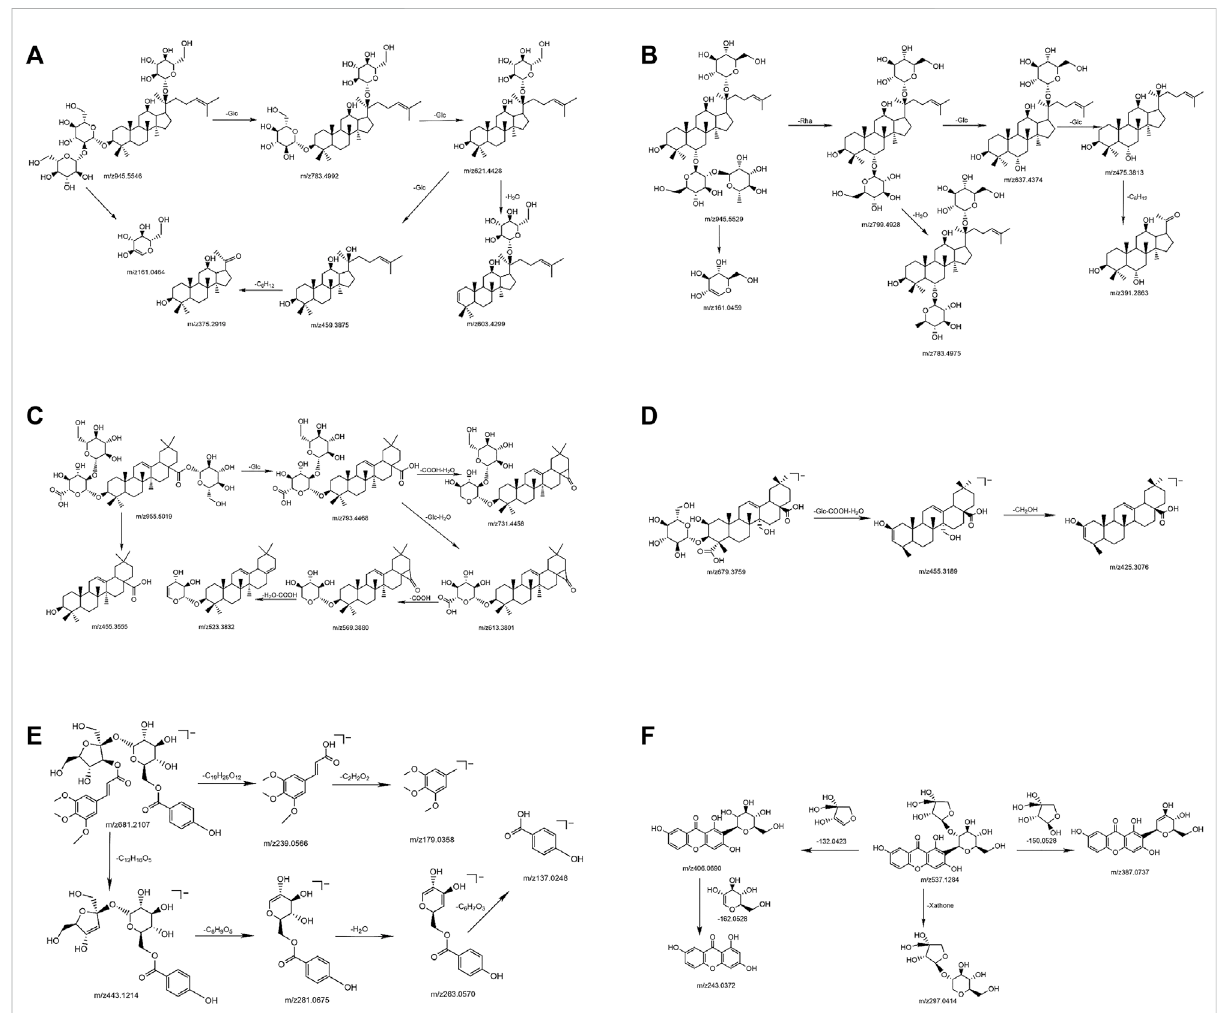
FIGURE 3 The possible cleavage pathway of typical compounds. GRd (A) ; GRe (B) ; GRo (C) ; Ten (D) ; TenA (E) ; and SB (F)